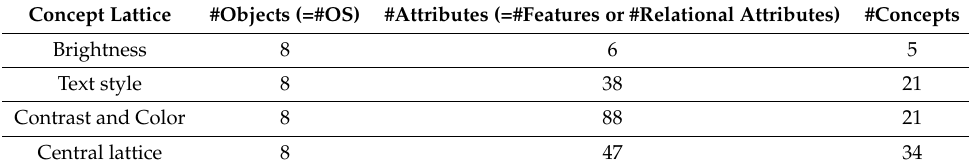
Table 8. Metrics on the objects, attributes and concepts for the case